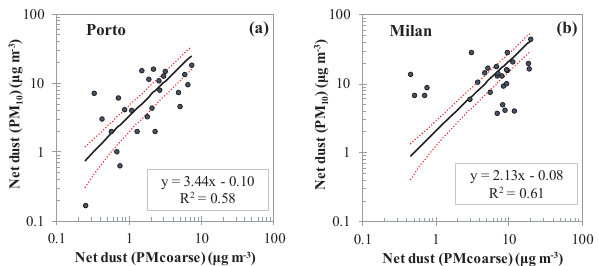
Figure 10. ATHENS: net dust versus PM 2 . 5 / PM 10 concentration ratios, when dust calculation is based on: (i) PM 10 concentrations (left) and (ii) the PM 10 mineral component